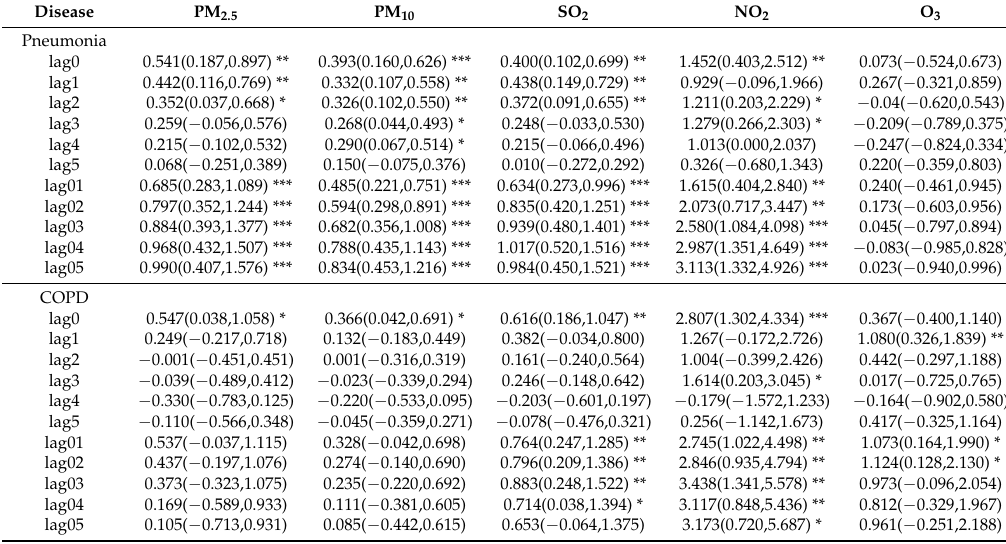
Table 5. The percent change and 95% CI for hospitalization due to subtypes of respiratory disease associated with a 10- µ g/m 3 increases in air pollutants concentrations in single-pollutant models. Disease PM 2.5 PM 10 SO 2 NO 2 O 3 Pneumonia lag0 0.541(0.187,0.897)